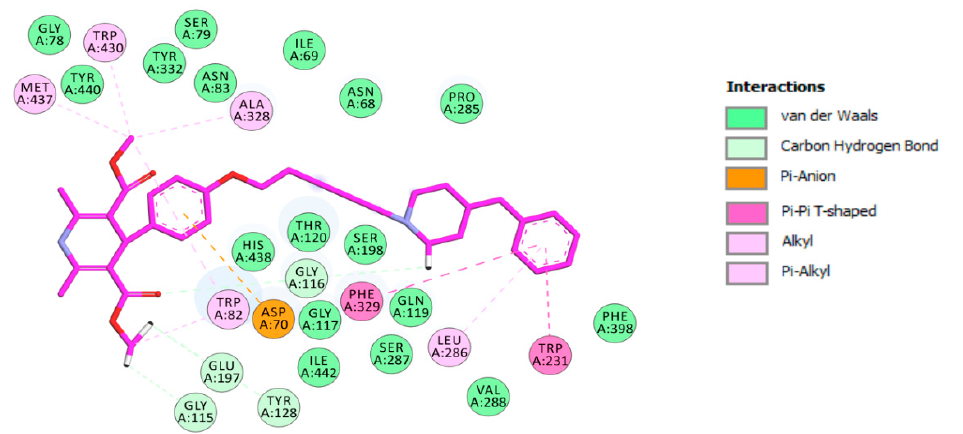
Figure 4. Two-dimensional schematic view of the interactions between 3h and hBChE.